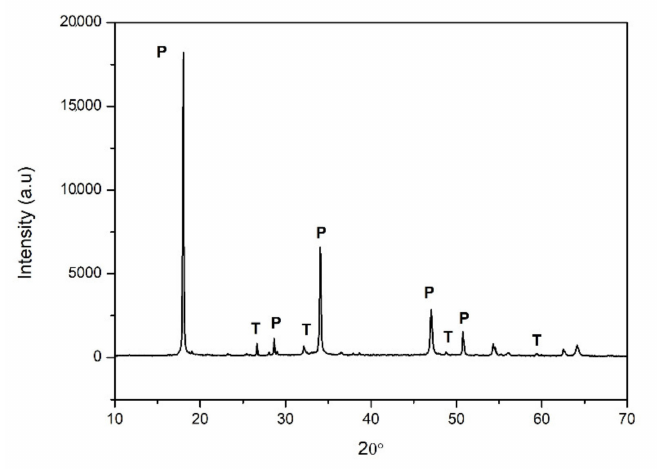
Figure 1. X-ray diffraction pattern of lime putty sample. P: Portlandite, T: Thenardite.